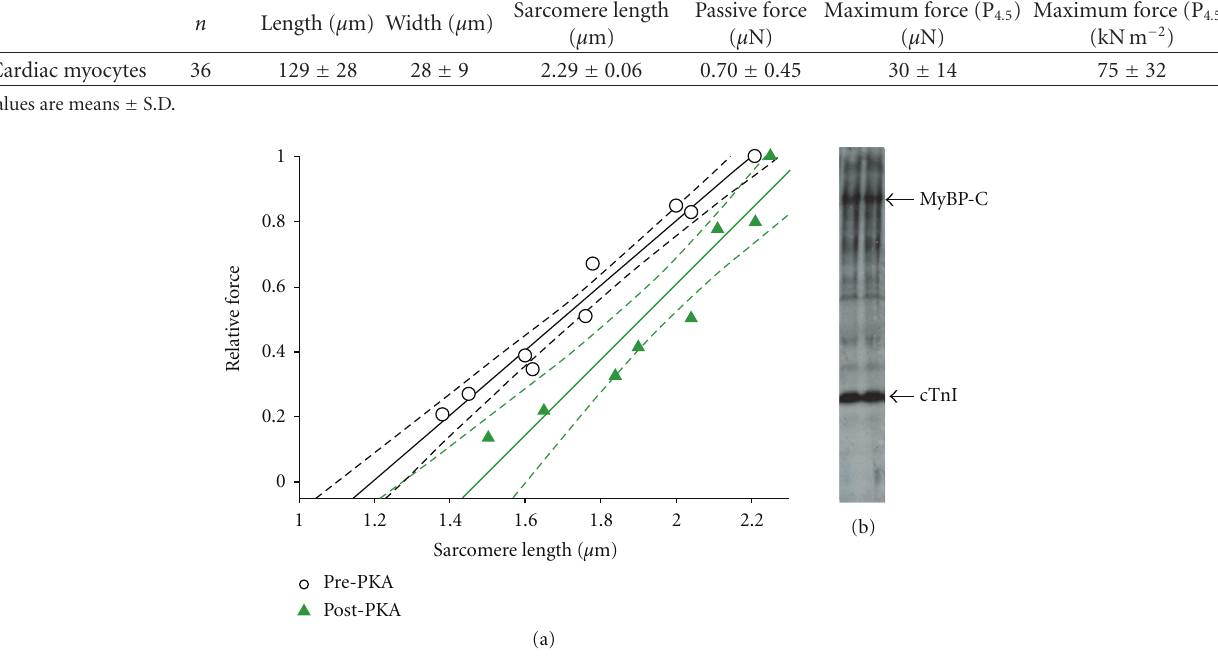
Figure 2: (a) Pig cardiac myocyte sarcomere length-tension relationships before and after PKA treatment. PKA-induced phosphorylation markedly steepened the length-tension relationship. (b) An autoradiogram showing radiolabeled phosphate incorporation into pig cardiac myofibrillar proteins (MyBP-C and cTnI) upon PKA treatment. Without PKA treatment, there was no radiolabelled ATP incorporation (data not